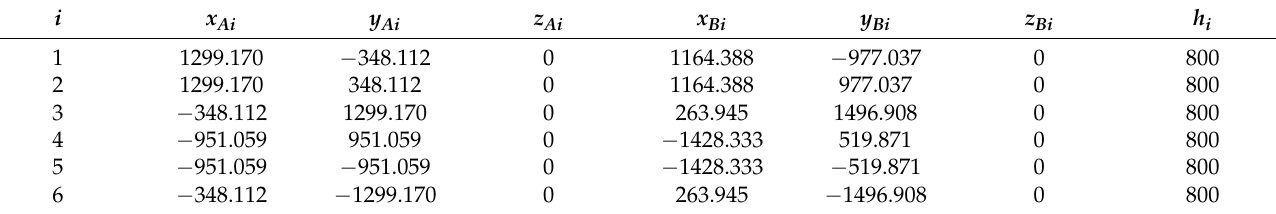
Table 5. New theoretical kinematic parameters (unit: